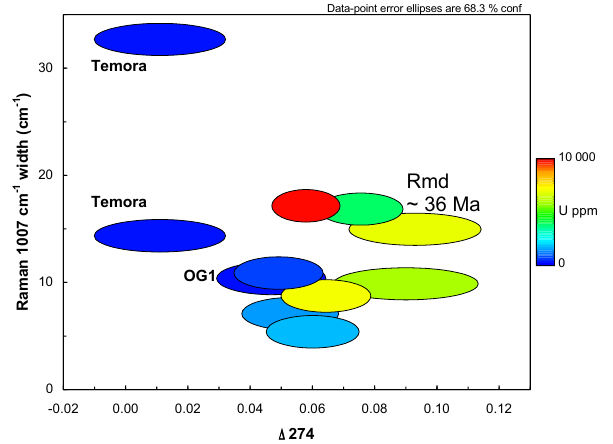
Figure 11. Comparison of (cid:49) 274 vs. Raman peak width for selected ∼ 37Ma Raumid zircon grains. Standard reference zircons OG1 and Temora are shown for